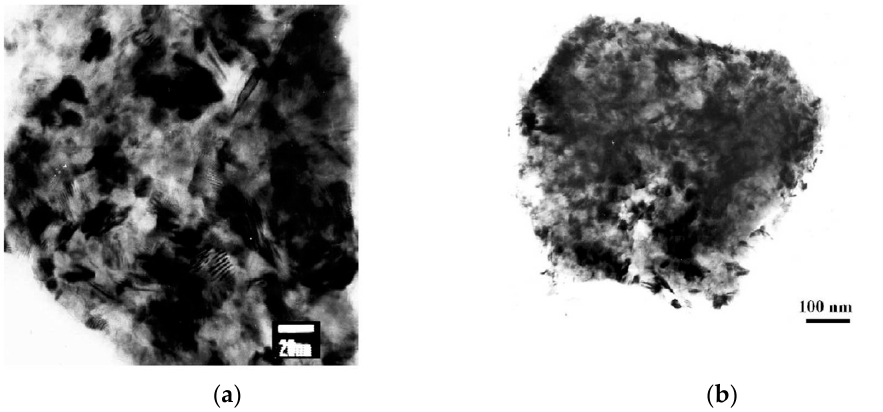
Figure 3. ( a ) Transmission electron microscopy (TEM) image of the Ti–B–Cu powder, HEBM for 2 min, ( b ) TEM image of the Cu–57 vol.% TiB 2 composite powder (the product of SHS reaction was HEBM for 5 min). Reprinted from [26], Copyright (2006), with permission from